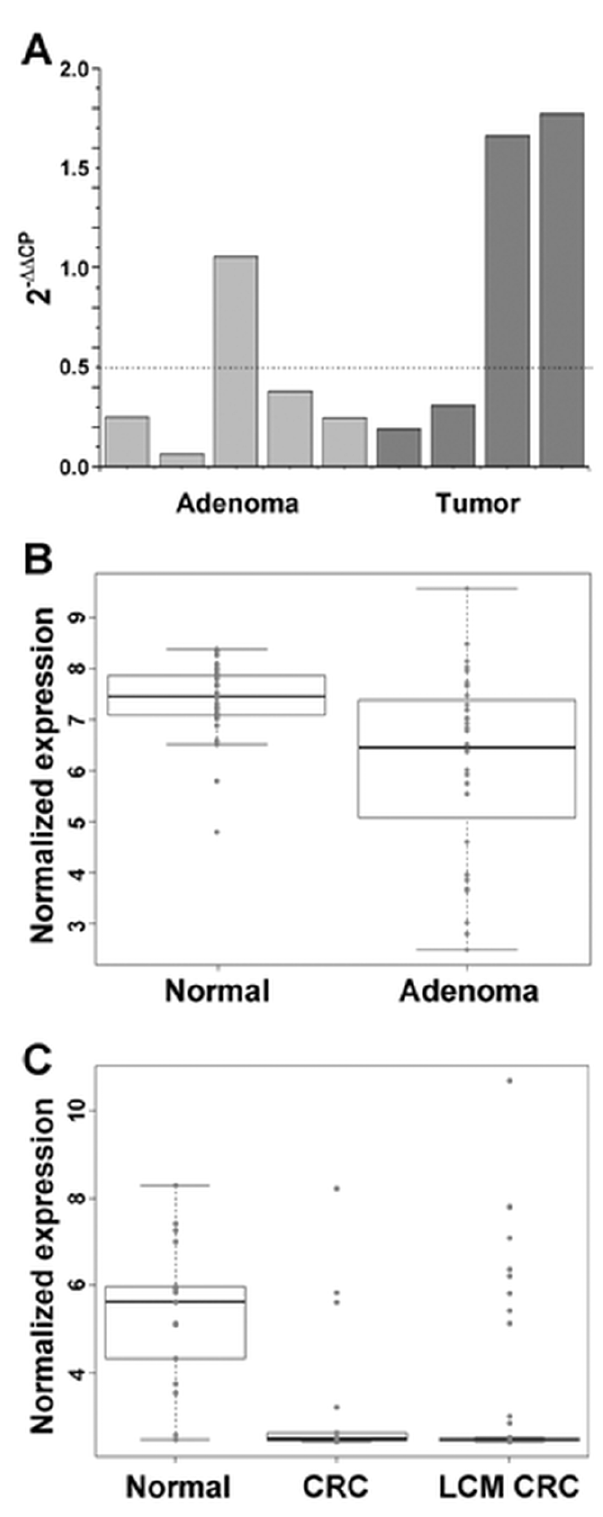
Figure 4. Heterogeneity of PTGDR mRNA expression levels in laser microdissected adenoma and tumor samples. Real-time PCR and data analysis was carried out as described in Materials and Methods. Genes were considered to be downregulated with 2 { DD CP values lower than 0.5 (50% decrease, horizontal dotted line) (A) Expression value distribution of the 215894_at probeset (for PTGDR gene) in the GSE8671 (B) and GSE18105 (C) GEO data sets. P